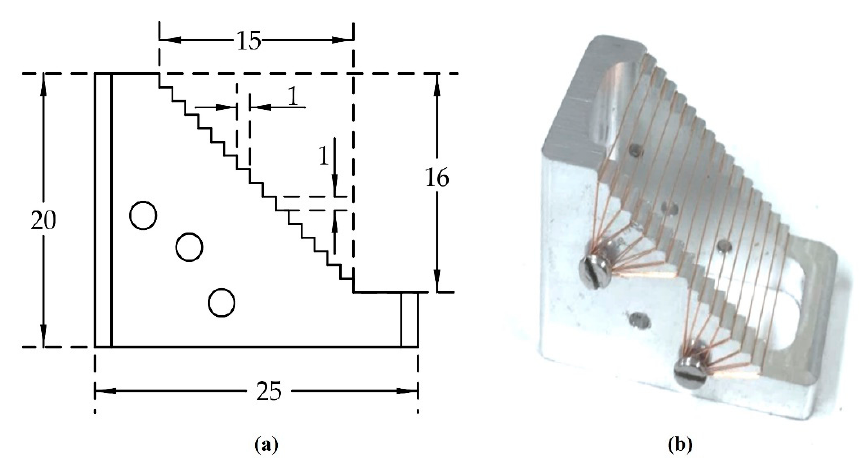
Figure 6. (a) The structure of the wire phantom. (b) A photograph of the wire phantom.